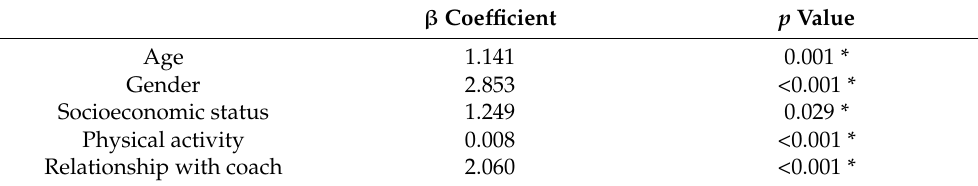
Table 5. Multiple regression analysis program components (physical activity, relationship with coach) and participant characteristics (age, gender, socioeconomic status) associated with resilience (primary